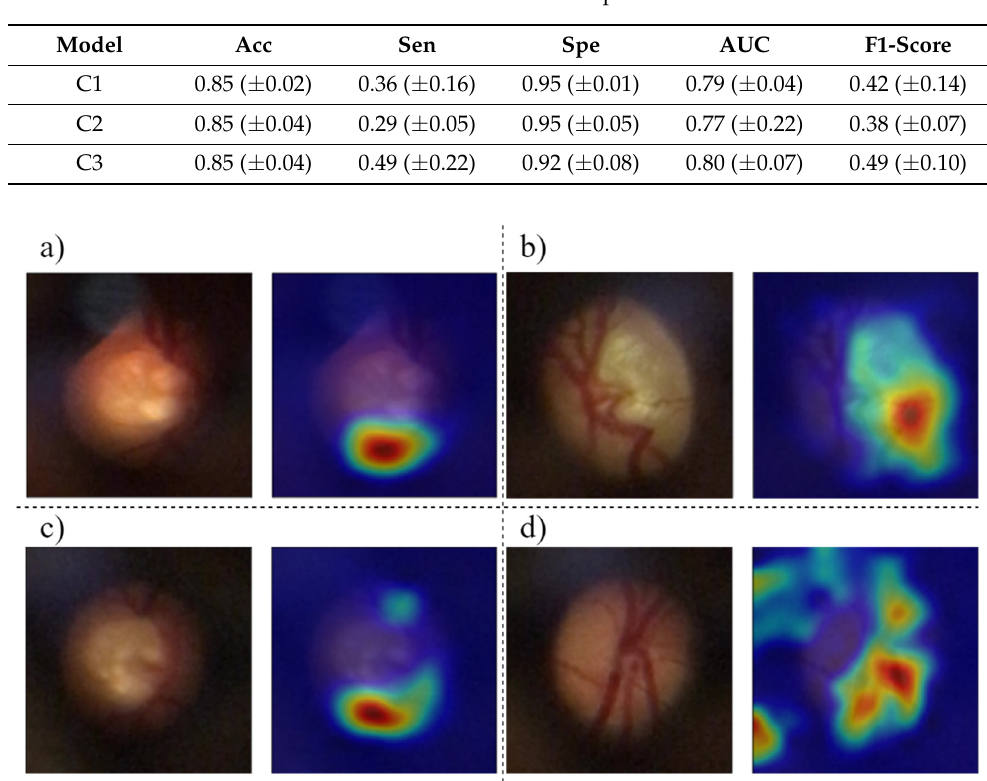
Table 9. Results for the models in K-fold CV for the leave-one-out test set with the respective mean and standard deviation for the 5 folds of each model.